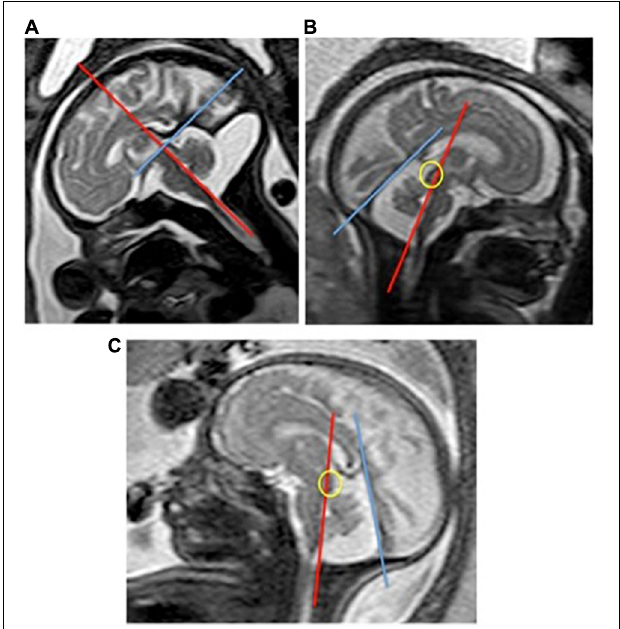
FIGURE 3 | Fetal MRI showing difficulties in the measurement of the BT angle. (A) Shows a fetal MRI where the tentorial surface is irregular due to the PFFC. The line that goes from the quadrigeminal plate and follows the tentorium does not represent the tentorial insertion in the occipital bone.